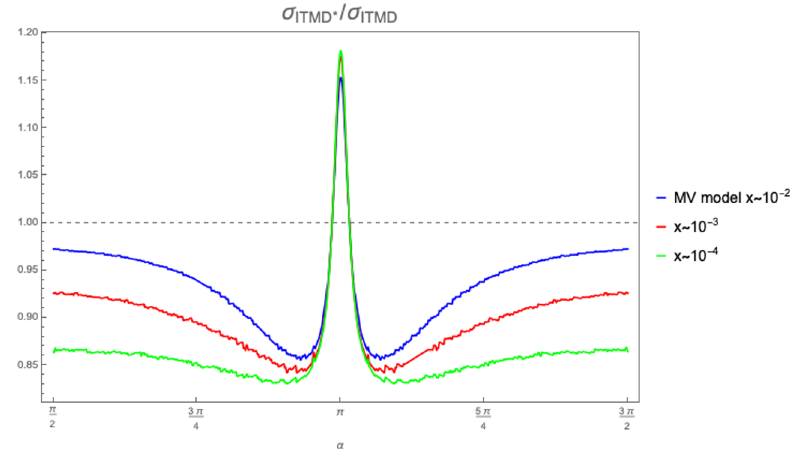
Figure 4 . Ratio of the pA → Q ¯ QX cross sections calculated in the ITMD* and ITMD frame- works, as a function of the angle α between the transverse momenta of the heavy quarks. Gluon TMDs are numerically evaluated in the MV model and evolved towards lower values of x with the JIMWLK equations.